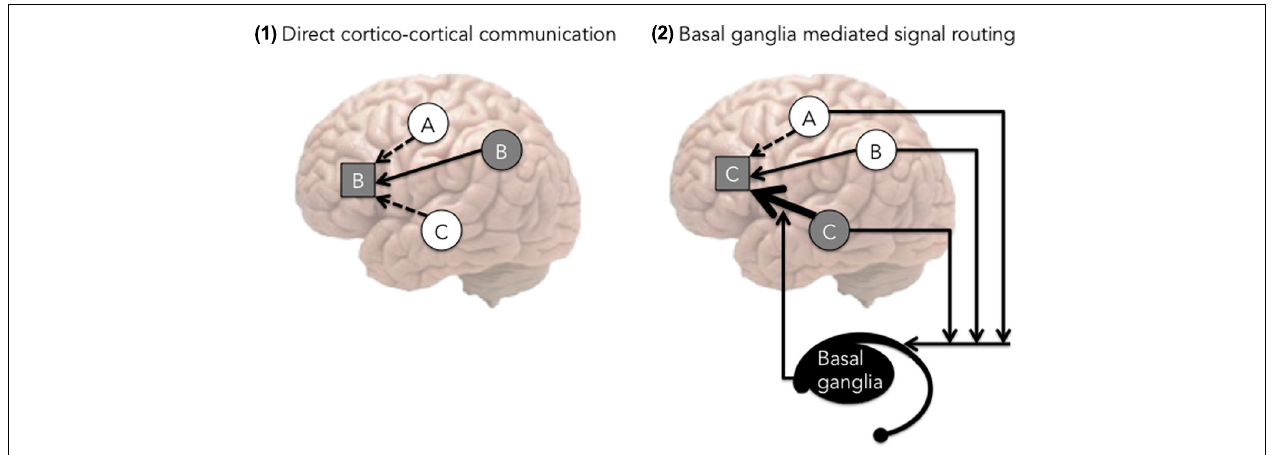
FIGURE 3 |The conditional routing model, adapted from Stocco etal. (2014). In this figure, Side 1 represents a prototypical situation, where prefrontal cortex (PFC) is receiving multiple concurrent signals. In this situation, the strongest concurrent signal (from region B) is most likely to affect the PFC (hence the figure shows the impact